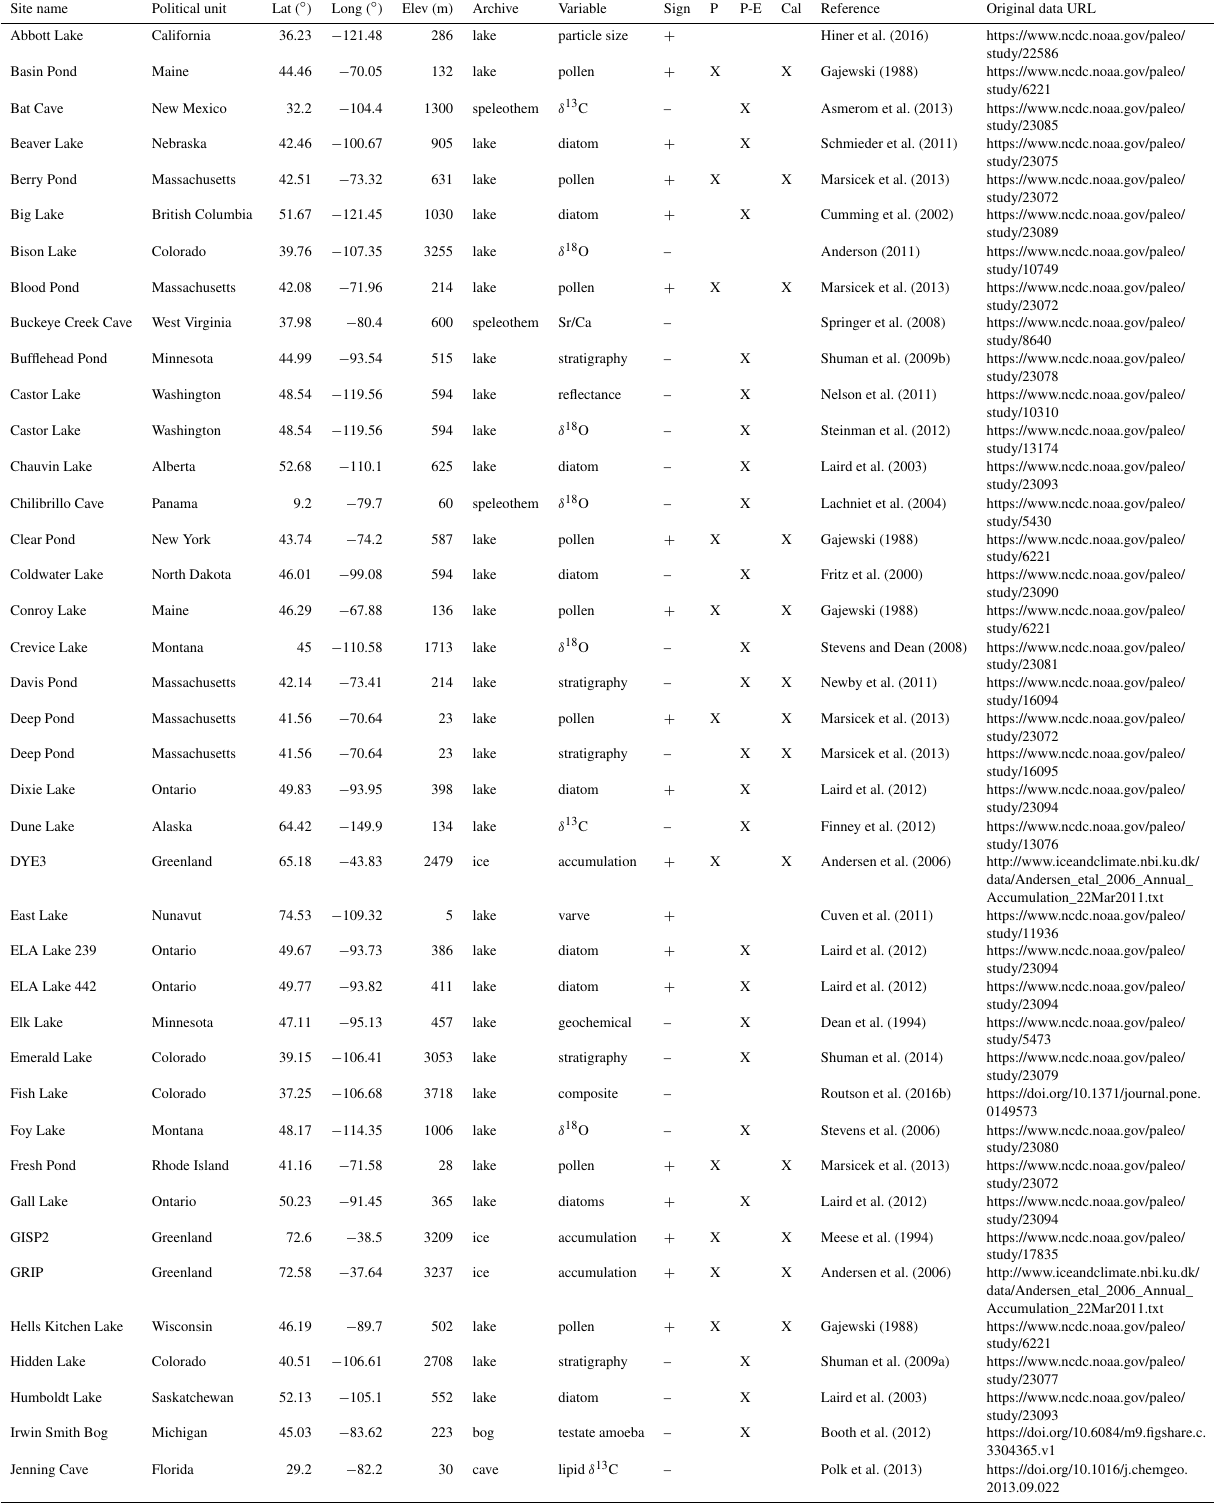
Table 1. Hydroclimate record data including latitude (Lat), longitude (Long), and elevation (Elev). Records sensitive to annual precipitation (P) and effective moisture (P-E) are indicated as records that have been calibrated to provide quantitative reconstructions (Cal). Sign refers to whether the variable has a positive or negative relationship to the hydroclimate inference (e.g., to effective moisture).